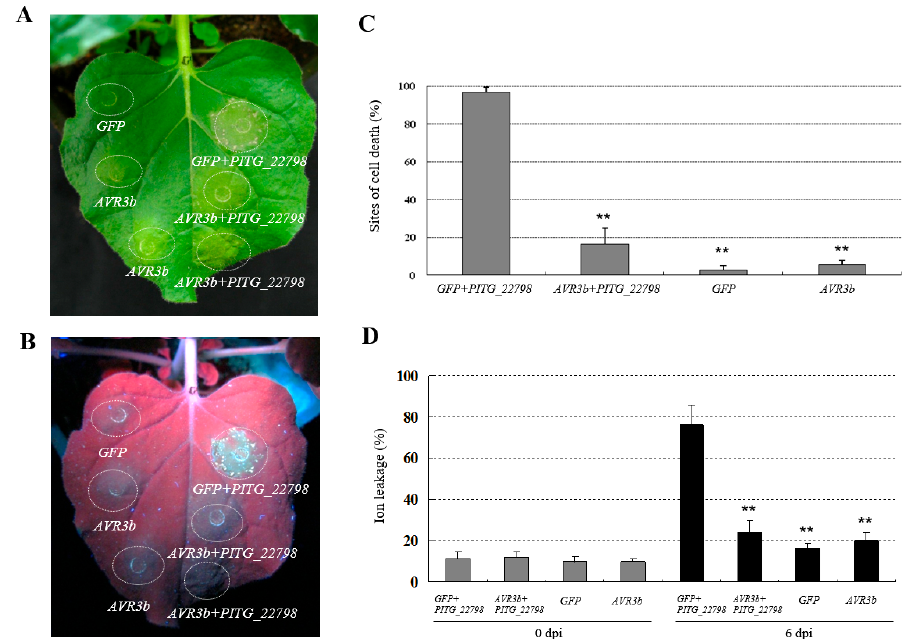
Figure 7. Avirulence 3b (AVR3b) suppresses the cell death induced by PITG_22798 . PITG_22798 and AVR3b were agro-co-infiltrated in N. benthamiana leaves in a 1:1 ratio with a final OD600 of about 0.4. GFP and AVR3b were used as negative controls. Photos were taken at 6 dpi under normal light ( A ) and UV light ( B ). ( C ) PITG_22798 -induced cell death is significantly reduced after co-infiltrated with AVR3b . Error bars represent SD. Results were obtained from 36 infiltration sites based on three independent experiments. Asterisks indicate significant difference from positive control ( p < 0.01, t -test). ( D ) PITG_22798 -induced ion leakage is significantly reduced after co-infiltration with AVR3b . Error bars represent SD. Asterisks denote values significantly different from positive control ( p < 0.01, t -test). Experiments were repeated three times with similar results.